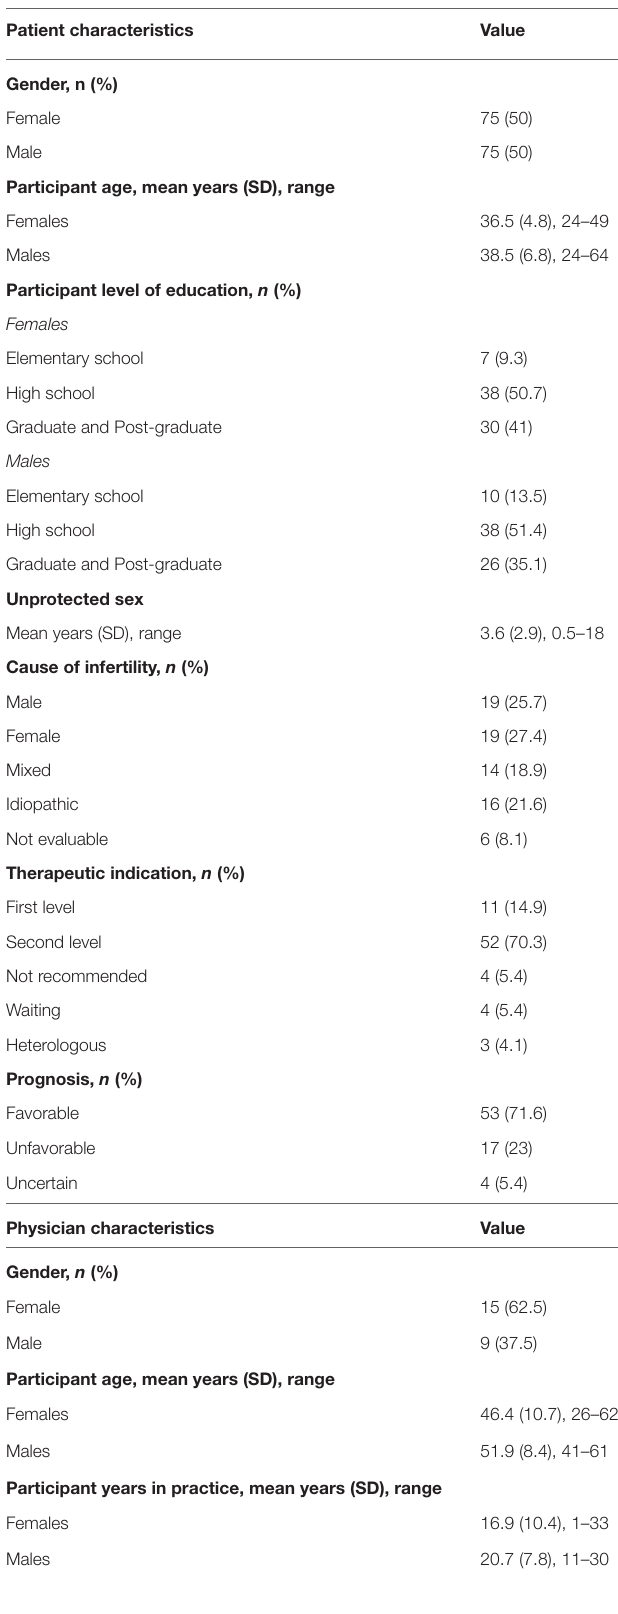
TABLE 1 | Participant sociodemographic and clinical characteristics. Patient